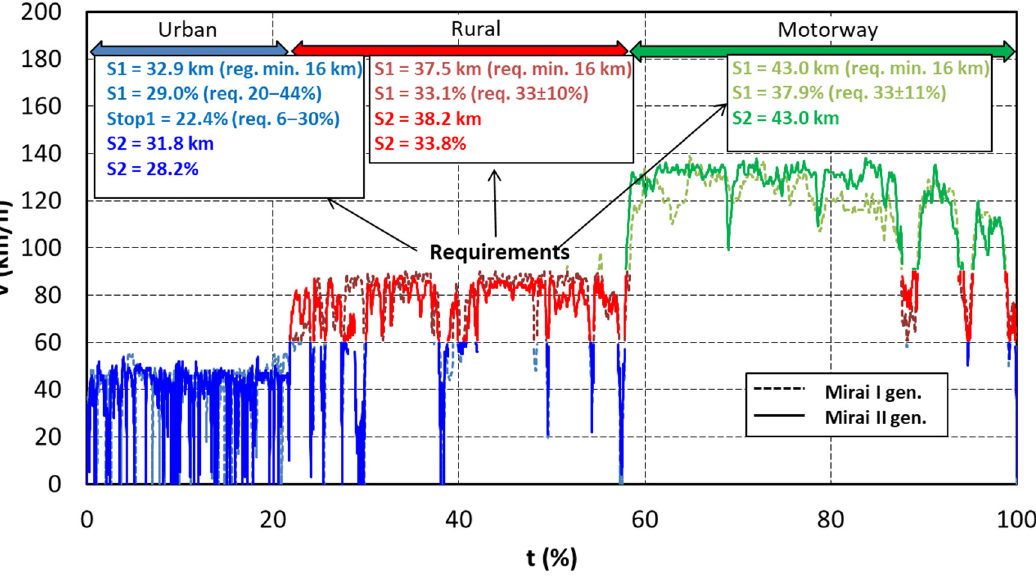
Figure 6. Comparison of speed profiles during two test drives of first-generation Mirai (dashed line) and second-generation Mirai (solid line).